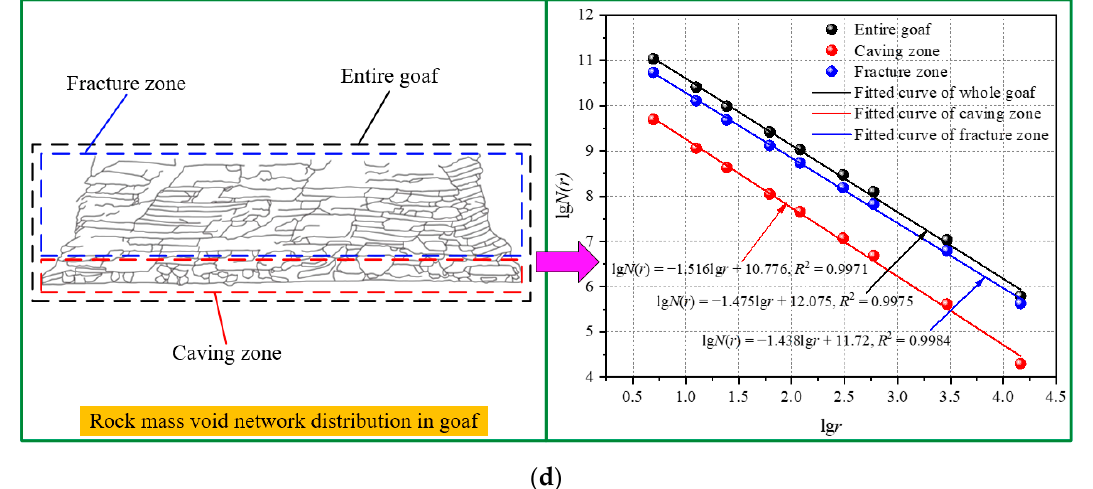
Figure 8. Calculation process of fractal dimension of overburden void of the model. ( a ) Working face advanced by 60 cm, ( b ) working face advanced by 80 cm, ( c ) working face advanced by 100 cm, and ( d ) working face advanced by 200 cm.